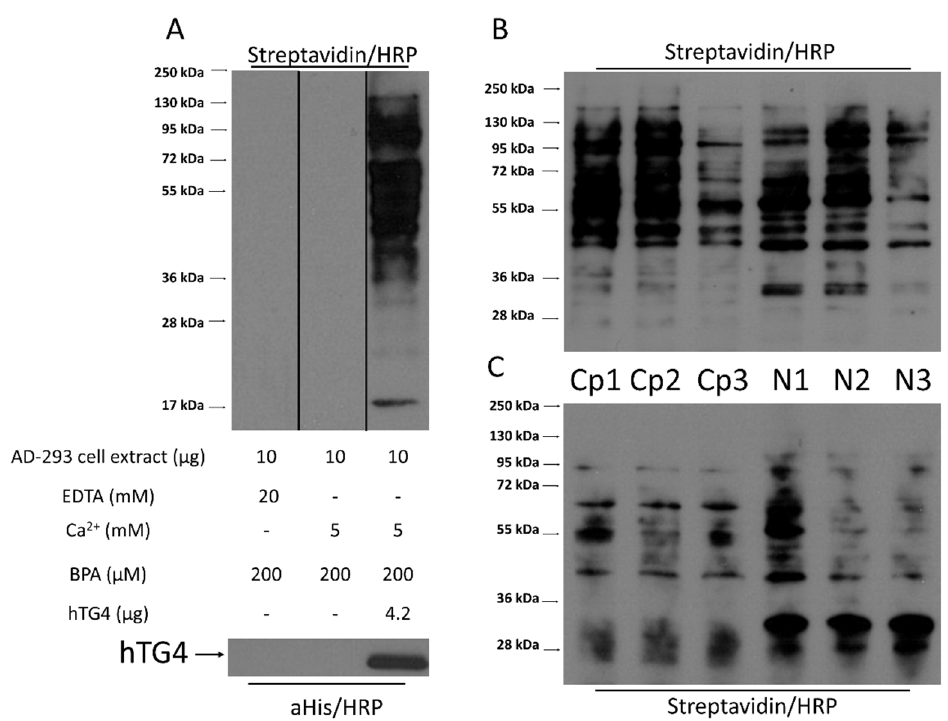
Figure 6. Verification of biotin-pentylamine (BPA) modified proteins in AD-293 cell extract upon incubation with hTG4. ( A ) BPA incorporation via hTG4 transamidase activity into AD-293 cell extract examined by Western blot, using Streptavidin/HRP for detection. The bottom part of the Western blot picture shows the presence of hTG4 in the sample, detected using anti-polyHis/HRP. The vertical lines on the blot indicate the place of the membrane cuttings. Representative picture from two independent experiments. The reaction conditions are summarised in the picture. BPA incorporation into AD-293 cytoplasmic (Cp) and nuclear (N) fractions directly after the enzyme reaction ( B ) and after the separation of the BPA containing substrates by NeutrAvidine Agarose ( C ). Western blots using Streptavidin/HRP for detection.